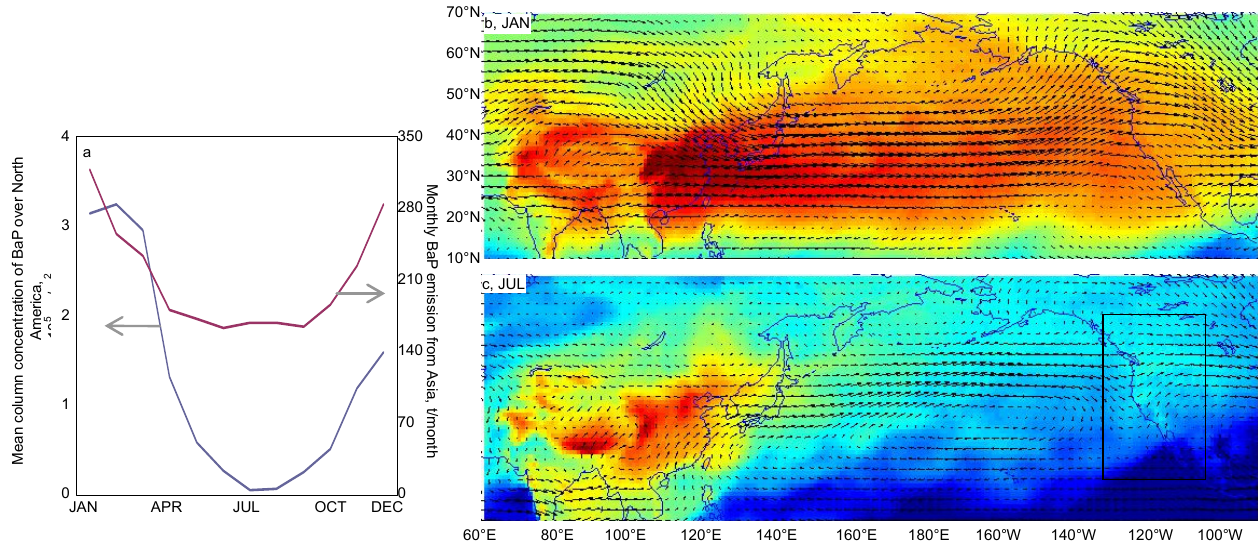
Figure 3 Seasonal variation of transpacific transport of BaP in 2004: a) monthly mean column BaP concentration over North America (blue curve, the region was shown as the black rectangle in panel c), which was chosen as an indicator of transpacific transport of BaP; the monthly emission flux over Asia (brown curve) is also shown; b, c) monthly mean total BaP concentration in January and July, 2004 at a height of 1200 m above ground over the northern Pacific Ocean; the color bar is the same as that in Figure 2.